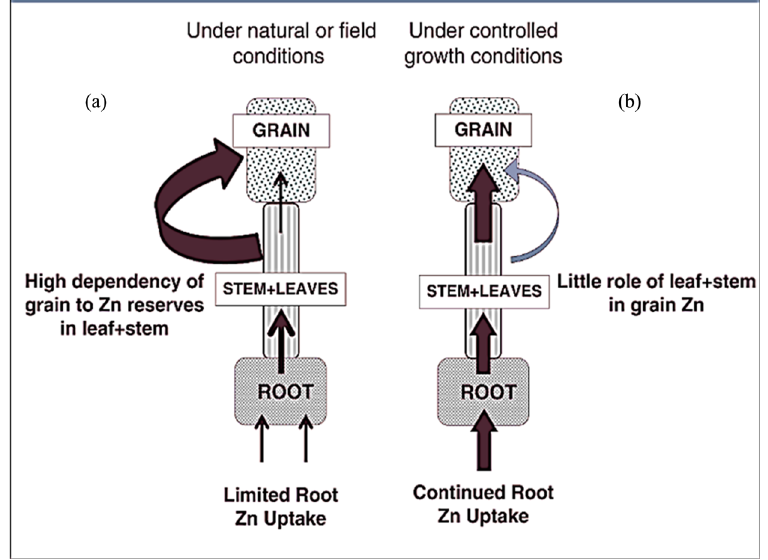
Figure 1: Zn uptake and re - translocation from root to vegetative organs then to grains of wheat: ( a ) plants under limited Zn and available water or both during seed ‐ fi lling; ( b ) plants under adequate water and Zn supply. ( Adapted from Cakmak and Kutman 2018. )